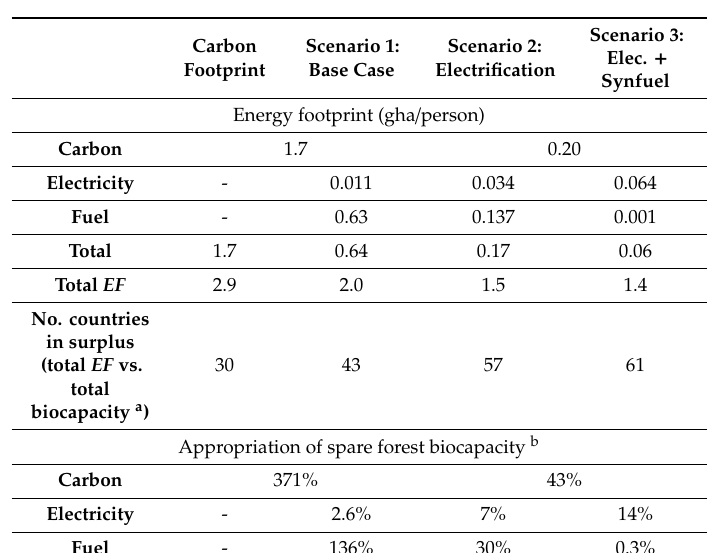
Table 4. Energy footprint related to total and forest